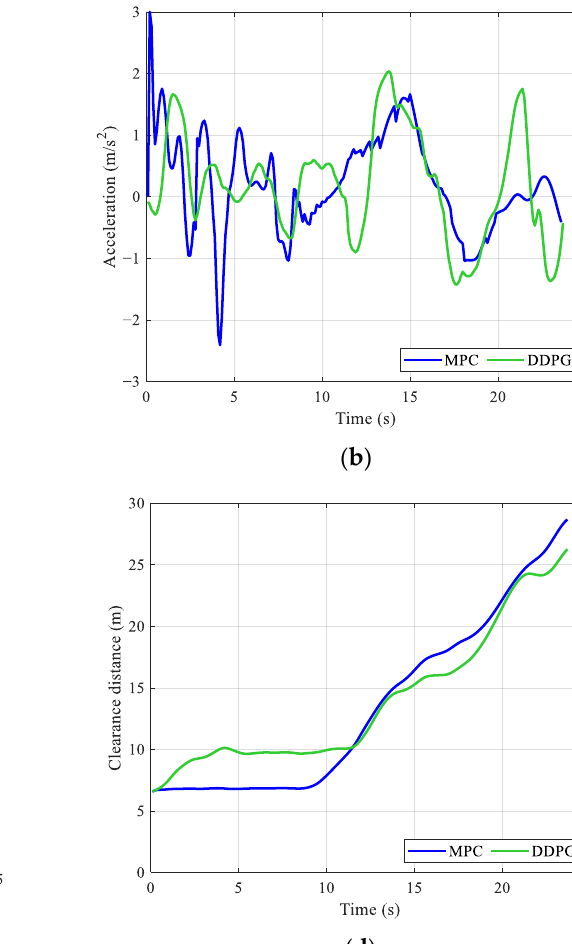
Figure 9. Speed control results for the AV with the leading vehicle No. 107 and a starting point at location 839 m on the sampled rough pavement: ( a ) speed, ( b ) acceleration, ( c ) jerk, and ( d ) clearance distance.